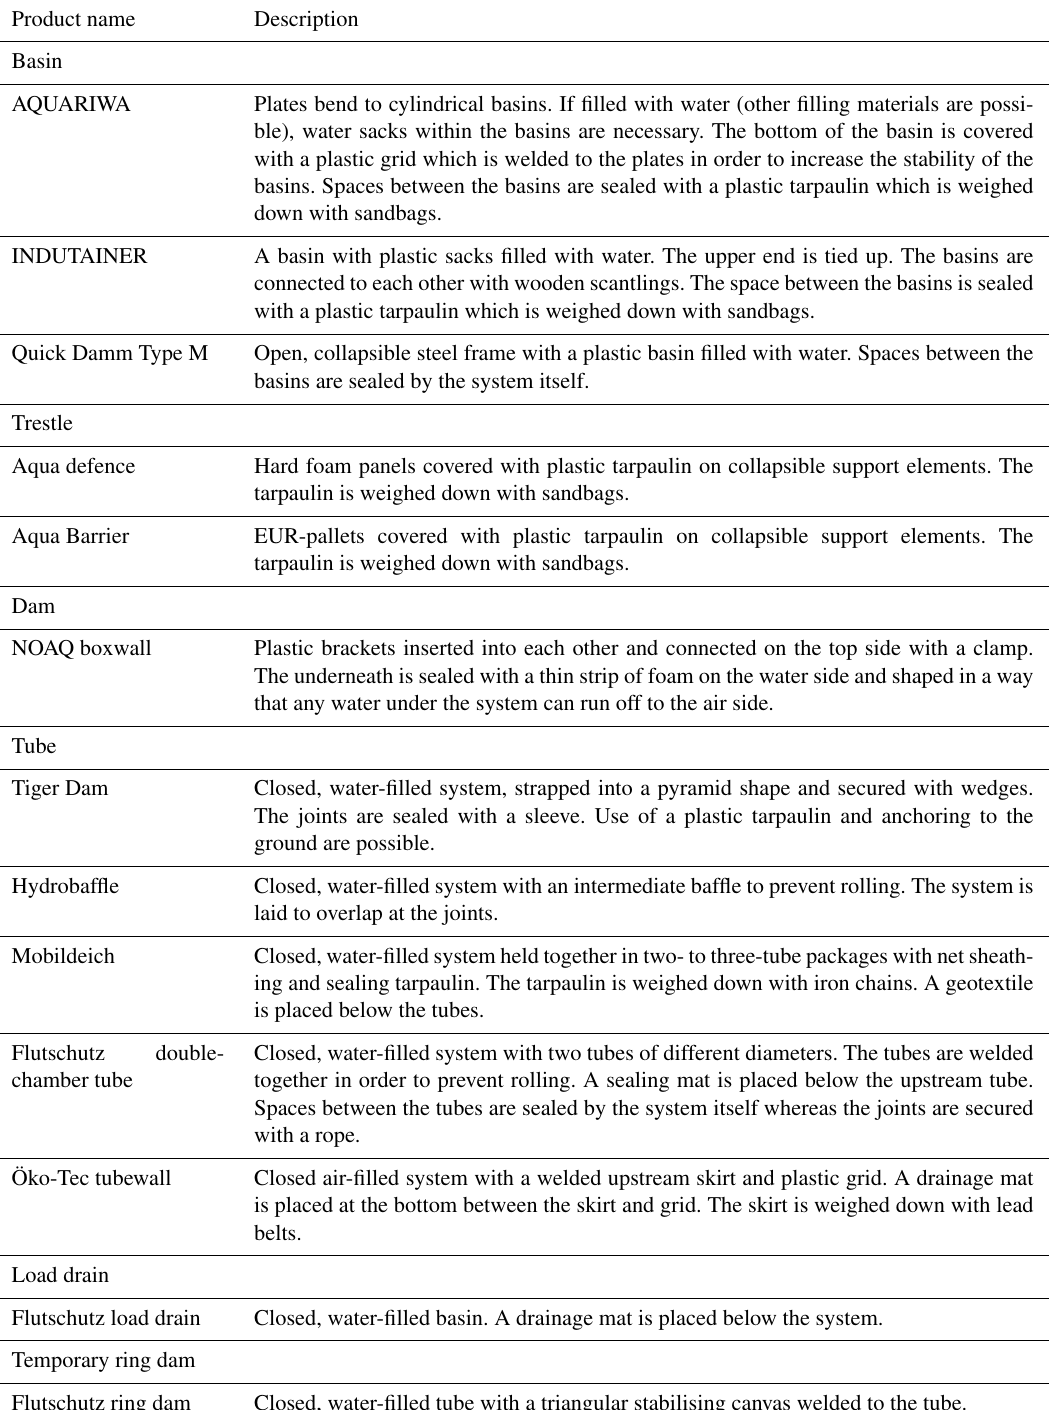
Table 1. Short description of the SBRSs